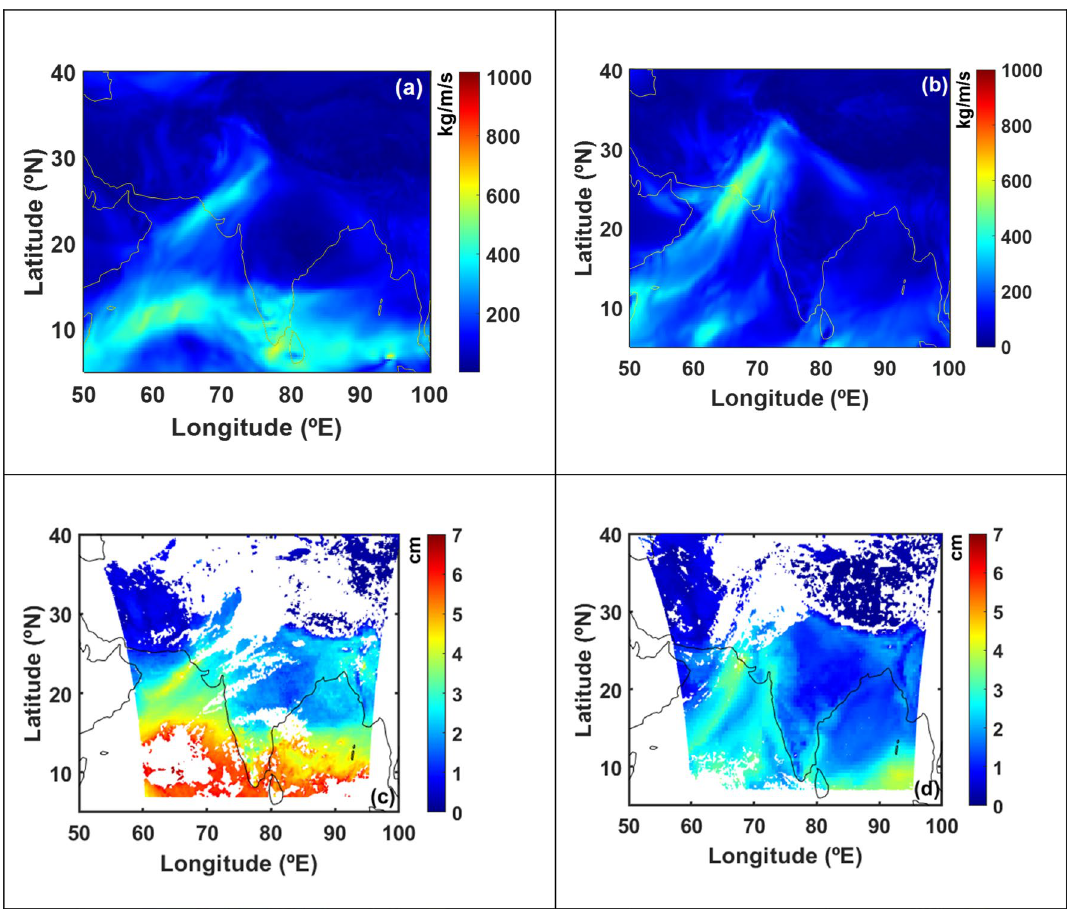
Figure 1. Atmospheric rivers (AR) over the west coast of India. Integrated horizontal water vapor transport (IVT, in Kg/m/s) values from reanalysis data over India and surrounding Ocean on ( a ) Dec 9, 2015 at 09UTC and ( b ) Jan 12, 2020 at 17UTC showing ARs at west coast of India. Satellite measured precipitable water vapor (PWV, in cm) during the AR events on ( c ) Dec 9, 2015 at 09UTC and ( d ) Jan 12, 2020 at 17UTC. White color in figures ( c ) and ( d ) indicate non-availability of data. Figure is generated using MATLAB R2020a software available at http:// in. mathw orks. com/ produ cts/ matlab/. (License no: occasional precipitation over this region. These synoptic weather systems provide moisture and contribute to low temperatures, which in turn favor the development of cold waves. However, IGP experienced a decline (or no significant trend) in the frequency of Western Disturbances 30 . In this study, for the first time, we present intense moisture incursion from Arabian Sea onto the west coast of India through 12–25° N corridor during December to January each year using remote sensing (2013–2020) and reanalysis (2000–2020) data. We link the finding to fog and haze intensification over IGP region as well as the recent hydro-climate signal observed over western Himalayas in recent decades. Atmospheric rivers. The vertically integrated horizontal water vapor transport (IVT) values on Dec 9, 2015 (at 09UTC) and Jan 12, 2020 (at 17UTC) over India and surrounding oceanic regions are shown in Fig. 1a,b, using reanalysis data. These figures illustrate southwesterly moisture transport from Arabian Sea onto the west coast of North India centred at around 24.66° N 67.20° E and 24.21° N 67.13° E. A narrow and elongated struc- ture of intense IVT features of around 2000 km in length and 500 km in width having IVT magnitude as high as 400 kg/m/s in the core. The description of atmosphere river (AR) characteristics 31 defined by the shape, extent and axis of horizontal moisture transport, that make landfall over the long narrow corridors, imply the pres- ence of ARs over the coastal region of North India during the winter season. This data is also complemented by satellite measured precipitable water vapor (PWV), shown in Fig. 1c,d, where PWV values are around 4 cm in the ARs core. Both IVT and PWV depict intense moisture transport in this region; however, IVT values show a better depiction of AR than PWV values. This is because of the fact that PWV represents the features associated with water vapor concentrations in the atmosphere, while the IVT captures the transport of water vapor (i.e., water vapor combined with winds) in the atmosphere. The total IVT (TIVT) within the ARs for Dec 9, 2015 and Jan 12, 2020 (shown in Fig. 1a,b), are 1.48 × 10 8 kg/s and 1.77 × 10 8 kg/s respectively (see Methods section for